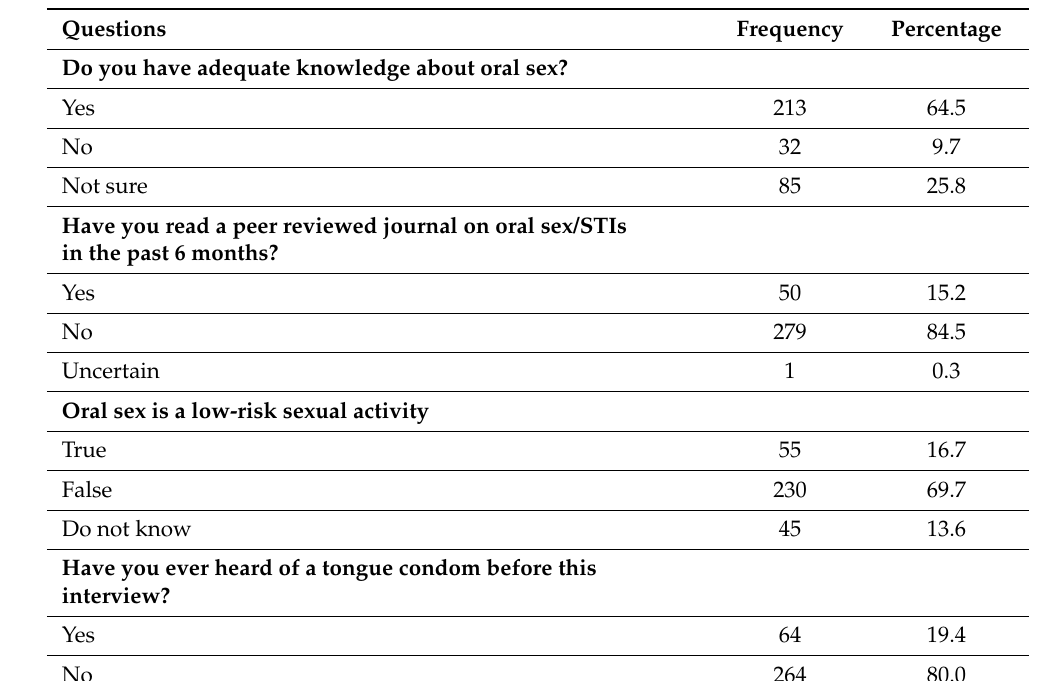
Table 2. Respondents’ knowledge on oral